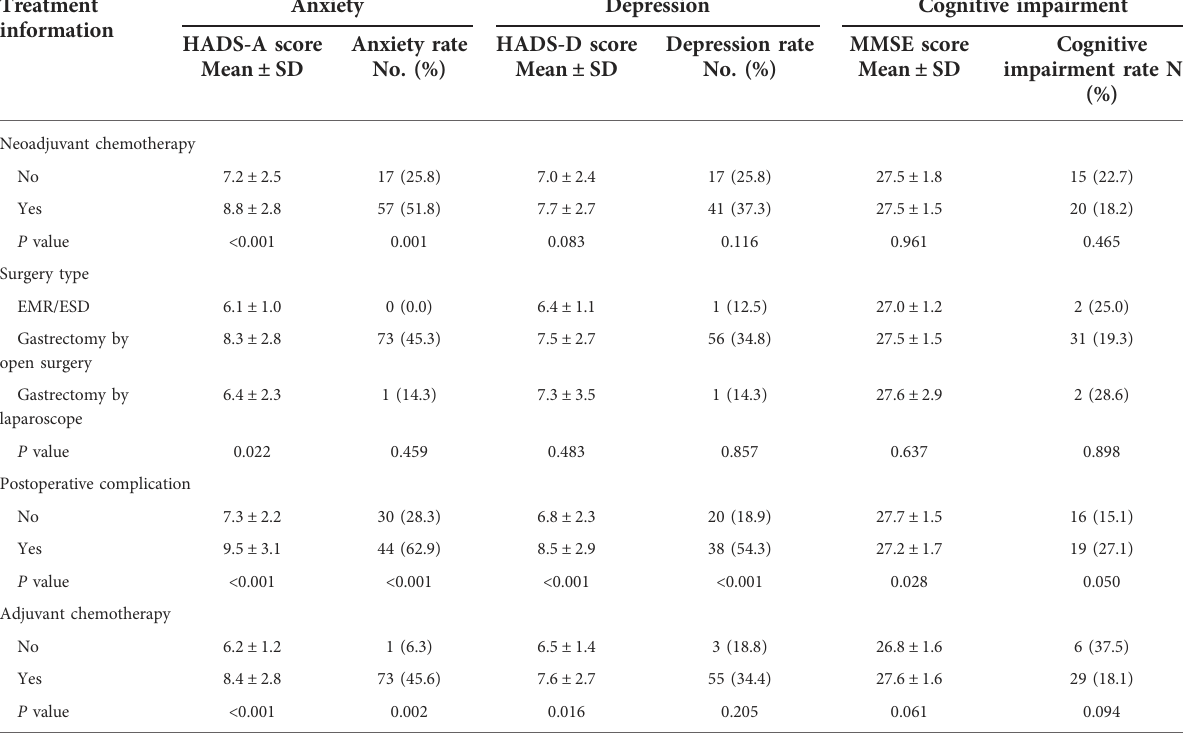
TABLE 4 Correlation of treatment information with anxiety, depression, and cognitive impairment. Treatment